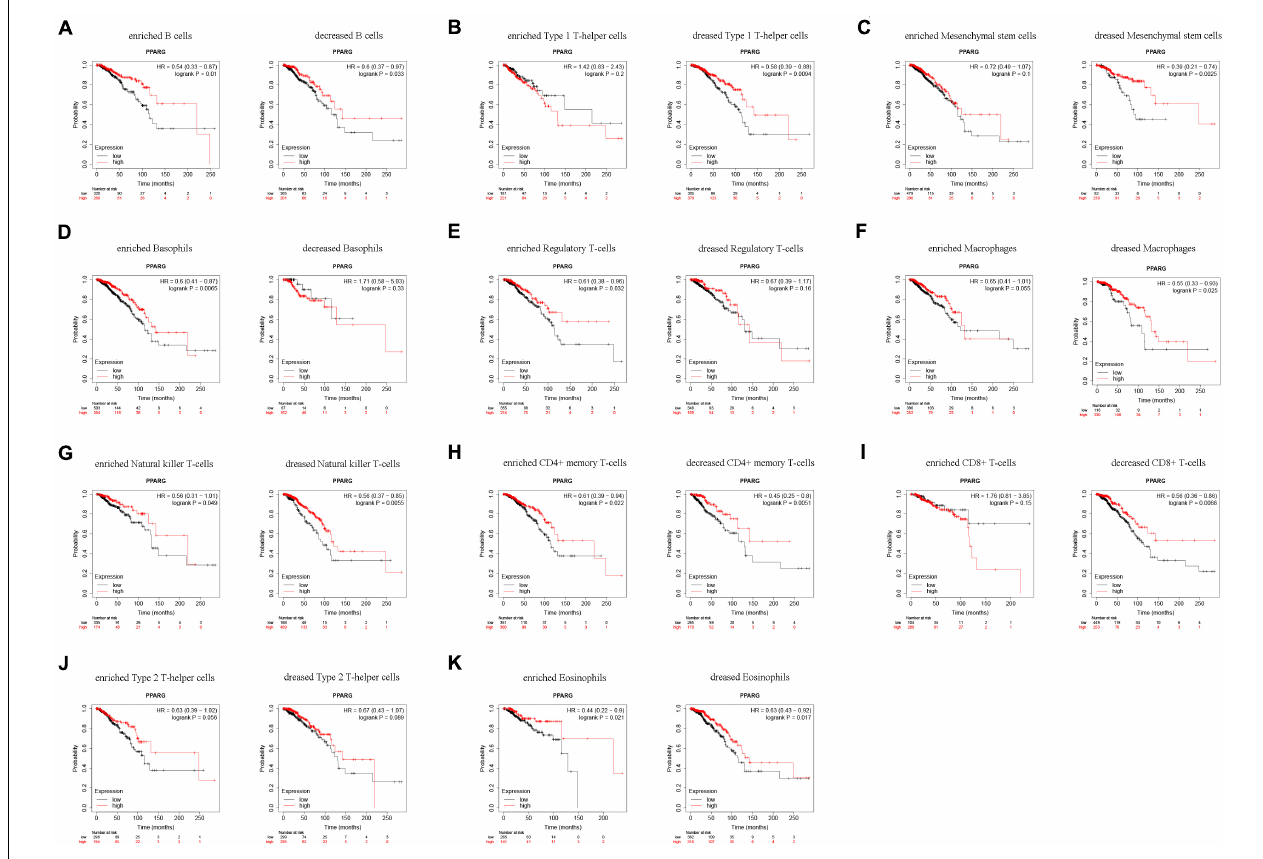
FIGURE 7 | Comparison of Kaplan-Meier survival curves of the high and low expression of PPARG in BRCA based on immune cells subgroups. (A–K) Relationships between PPARG of different immune cells subgroup and prognoses in